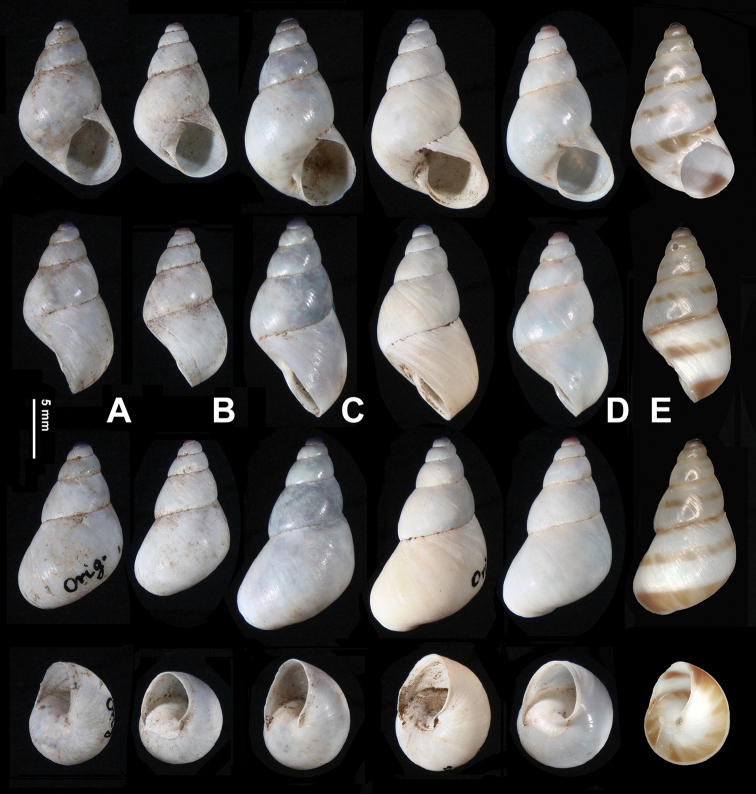
A–DSinorachis
onychinus (Heude, 1885) comb. nov., shells A SMF42825 B SMF42826 C SMF42827, SW Hupei D SMF104593 ESinorachis
baihu Wu & Chen, gen. and sp. nov., HBUMM08296-specimen 1, holotype.